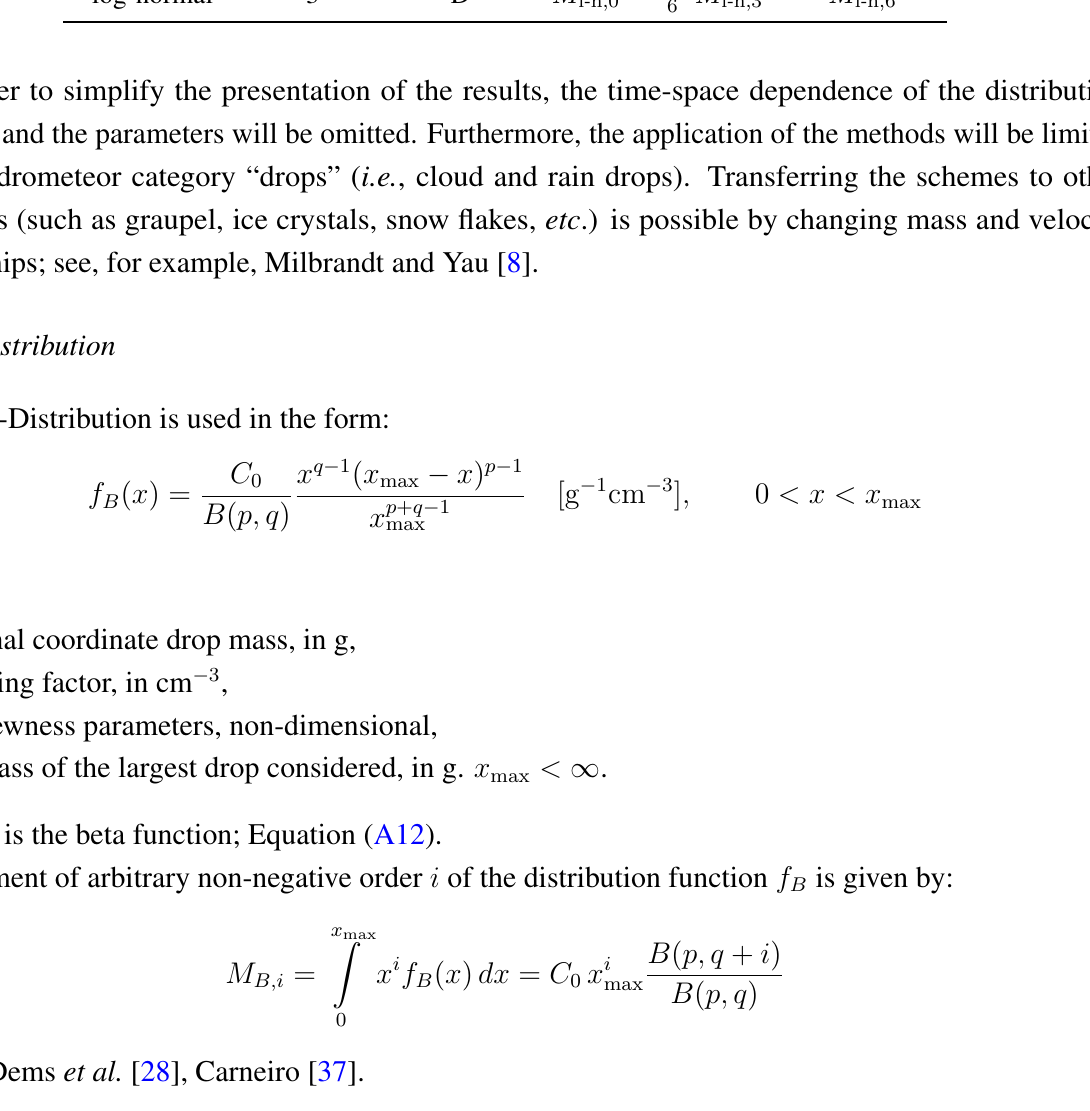
Table 1. Overview of the different distribution functions in the context of an method of three-moments (MOM3) scheme. x , drop mass; D , drop diameter; ρ Distribution # Param. Int.Coord. N L Z